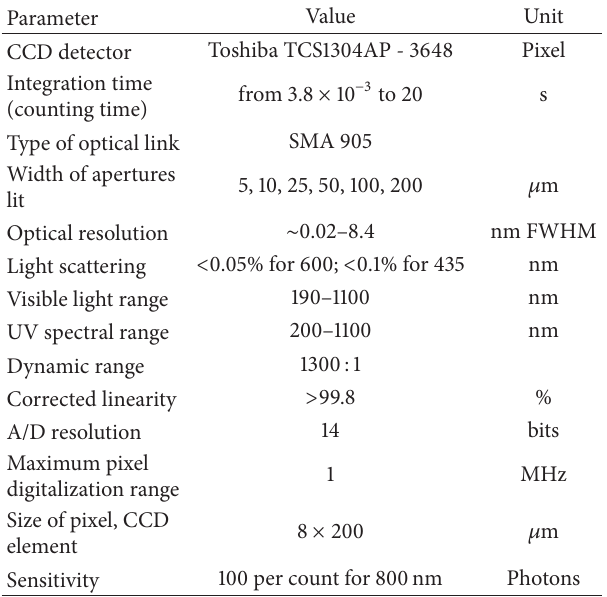
Table 1: Characteristics of technical parameters of spectrophotome- ter applied in the